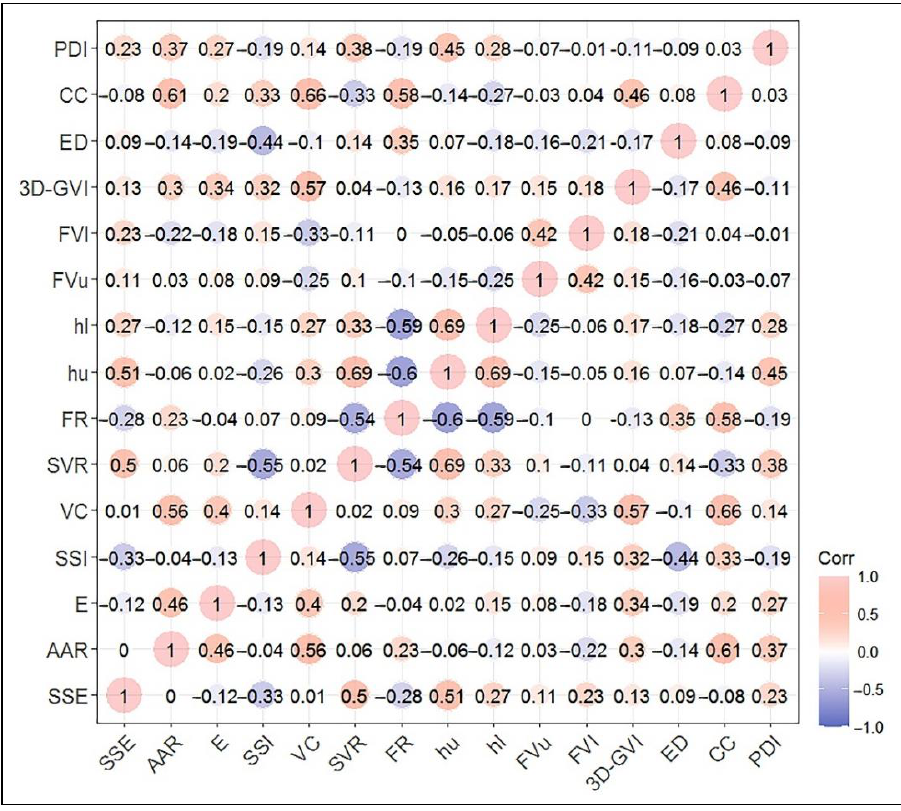
Figure 6. Results of correlation analysis.